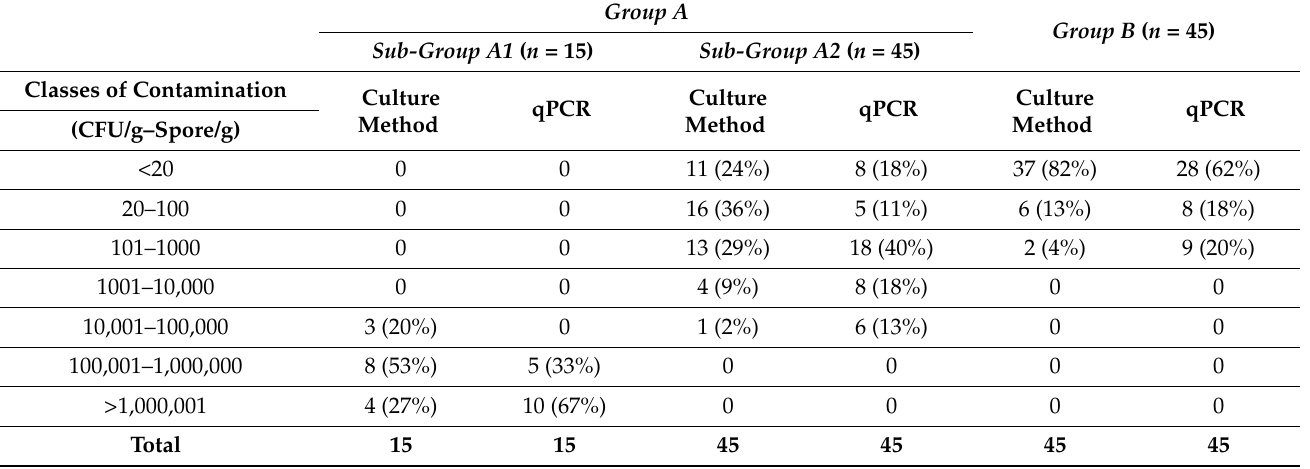
Table 2. Distribution of results obtained by microbiological and qPCR assays according to the different classes of contamination level expressed in terms of the CFU/g or spore/g of P. larvae ,